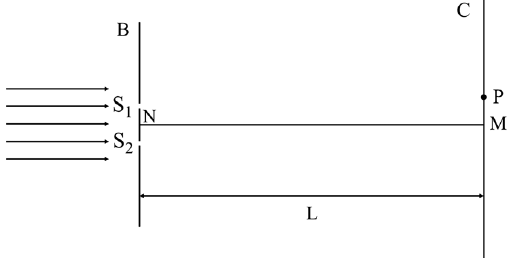
FIG. 2. Standard Young ’ s double slit experimental setup. It is also the problem setup used in Q1 – Q4, Q13, and Q14 of the